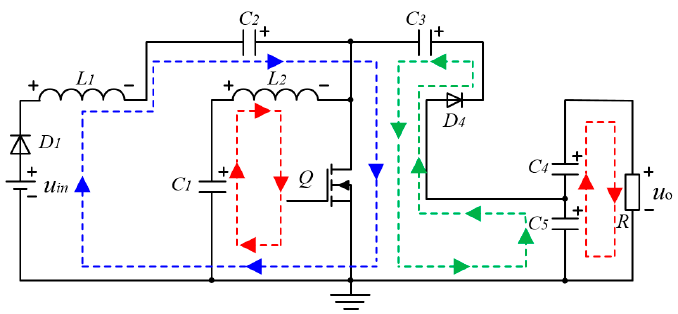
Figure 2. The circuit operation state when power switch Q is turned on.